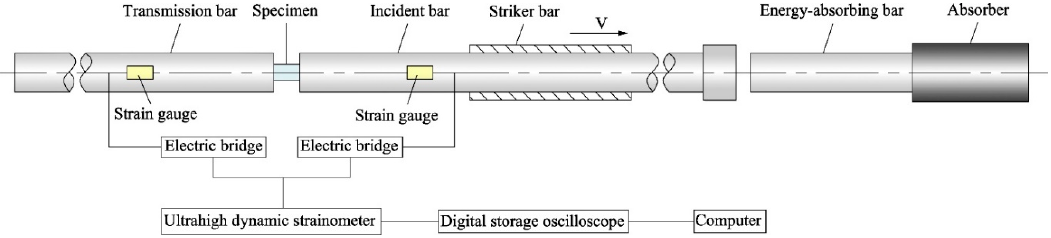
Figure 5. Schematic diagram of the split Hopkinson tensile bar apparatus.